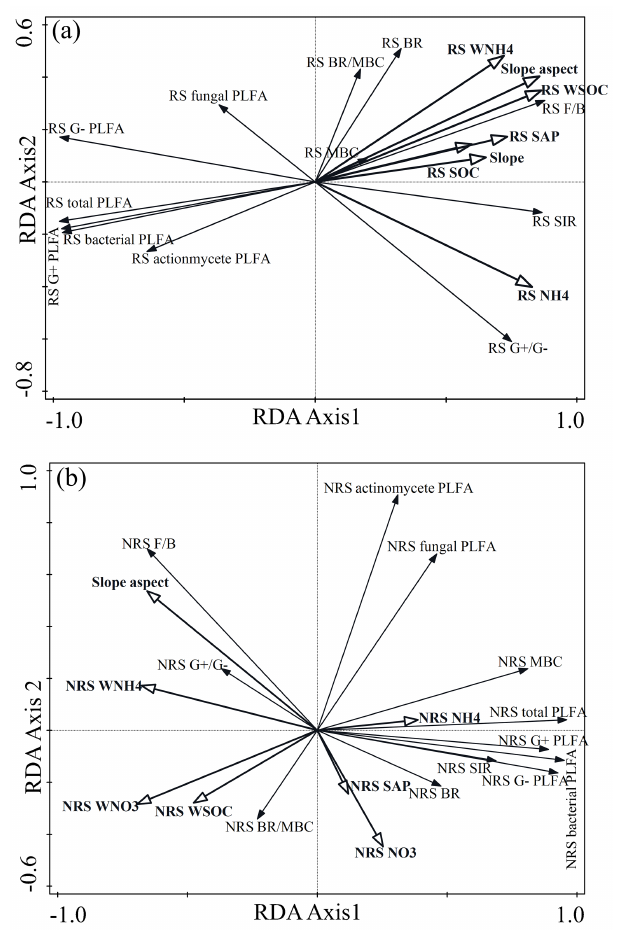
Figure 4. Bidimensional graph for a redundancy analysis (RDA) of the relationships between microbial properties and environmen- tal factors in the rhizospheric (a) and non-rhizospheric (b) soils. Note: RS, rhizospheric soil; NRS, non-rhizospheric soil; MBC, microbial biomass carbon; BR, basal respiration; SIR, substrate- induced respiration; F/B , the ratio of fungal PLFA content to bac- terial PLFA content; G + / G − , the ratio of G + PLFA content to G − PLFA content; SAP, available phosphorus; SOC, soil organic carbon; NH 4 , ammonium nitrogen; NO 3 , nitrate nitrogen; WSOC, water-soluble organic carbon; WNH 4 , water-soluble ammonium ni- trogen; WNO 3 , water-soluble nitrate nitrogen.